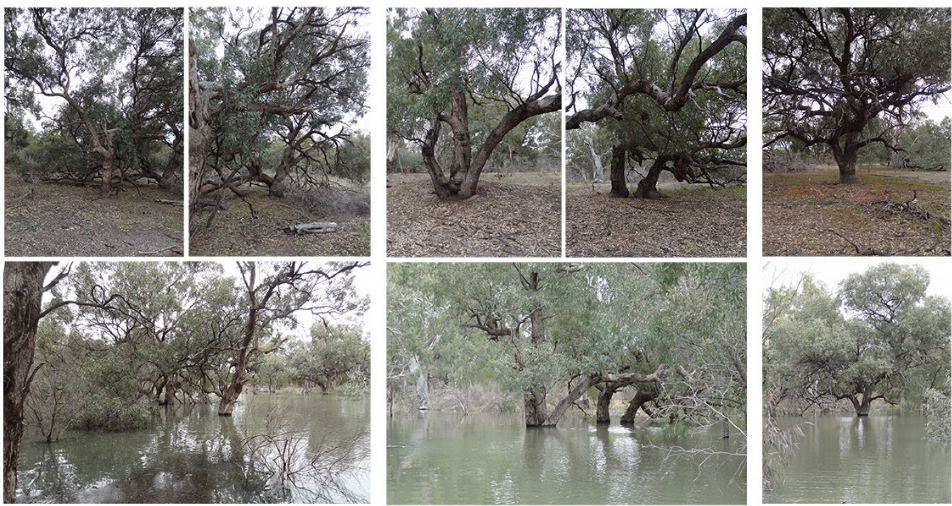
Figure 6. Essential flooding on a sandy riverine floodplain lake system assists native trees to access trace-metal nutrients [1] (Reprinted with permission from [1]. Copyright 2021 Copyright Department of Ecology in